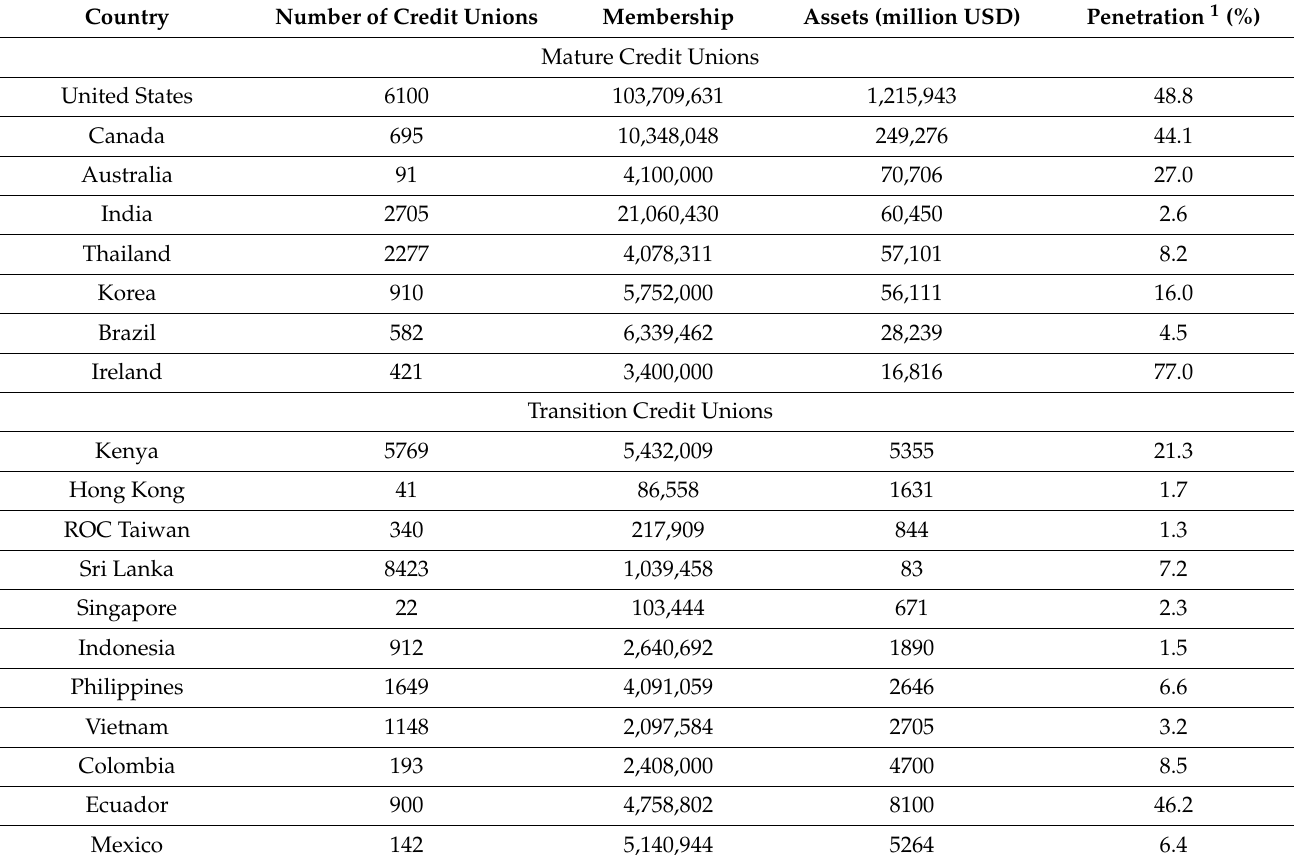
Table 2. Geographic location of movement